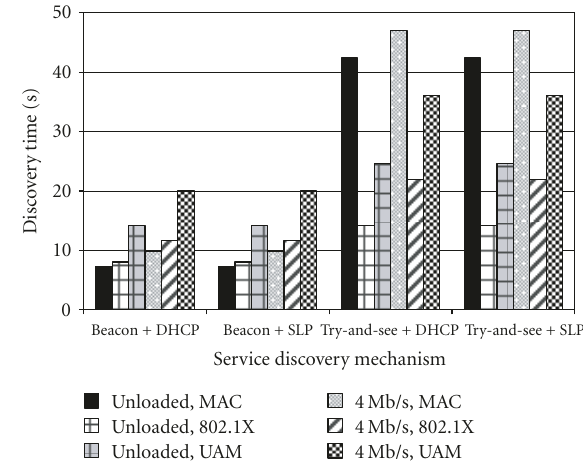
Figure 11: Web browsing: service discovery